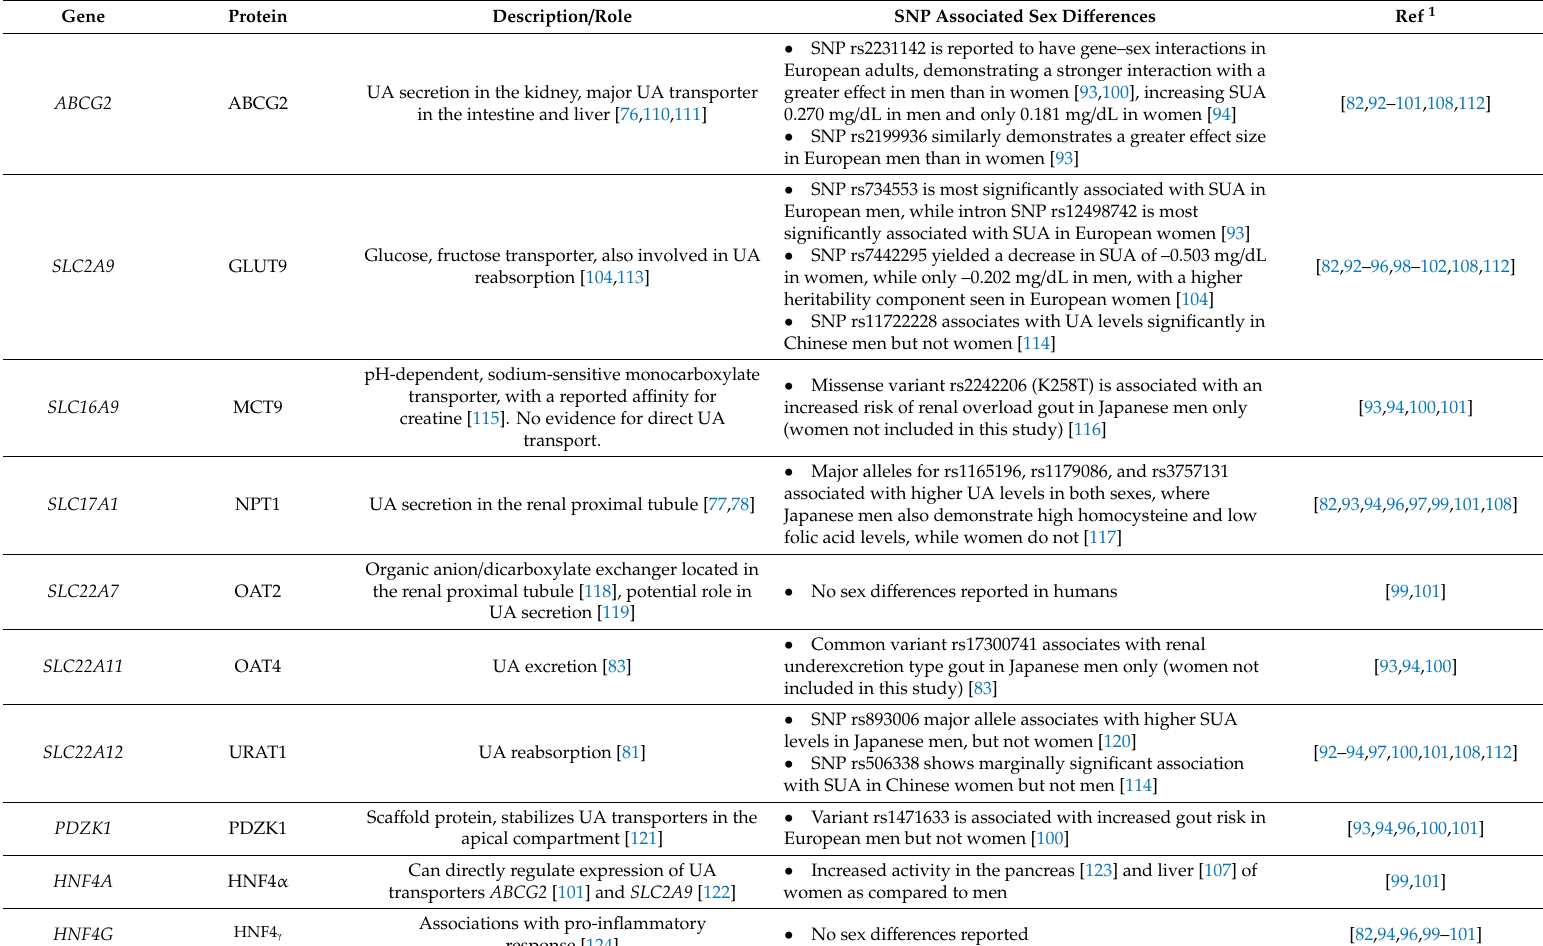
Table 2. Reported sex di ff erences in UA associated transporters and regulators involved in UA